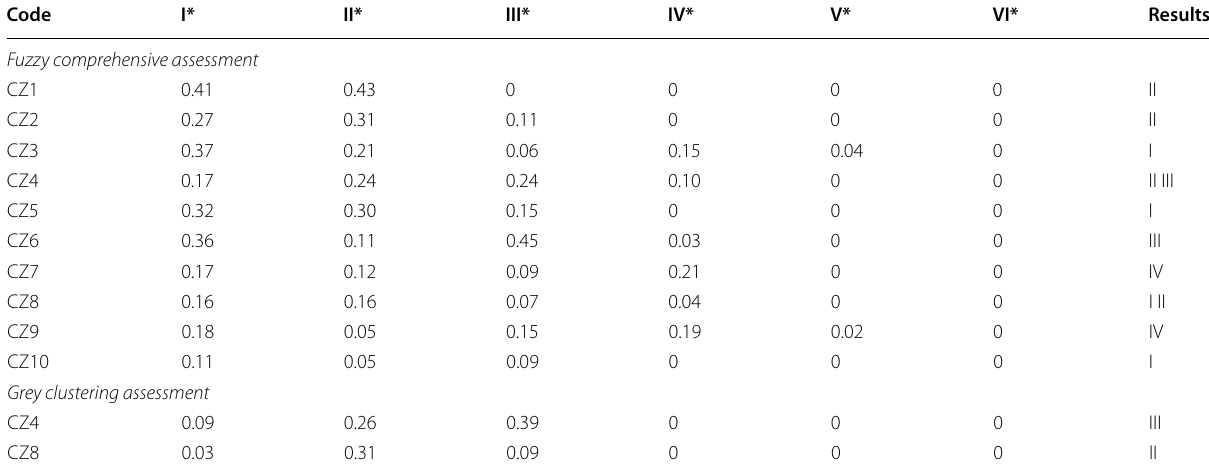
Table 6 Fuzzy comprehensive and grey clustering assessment results Code Fuzzy comprehensive assessment